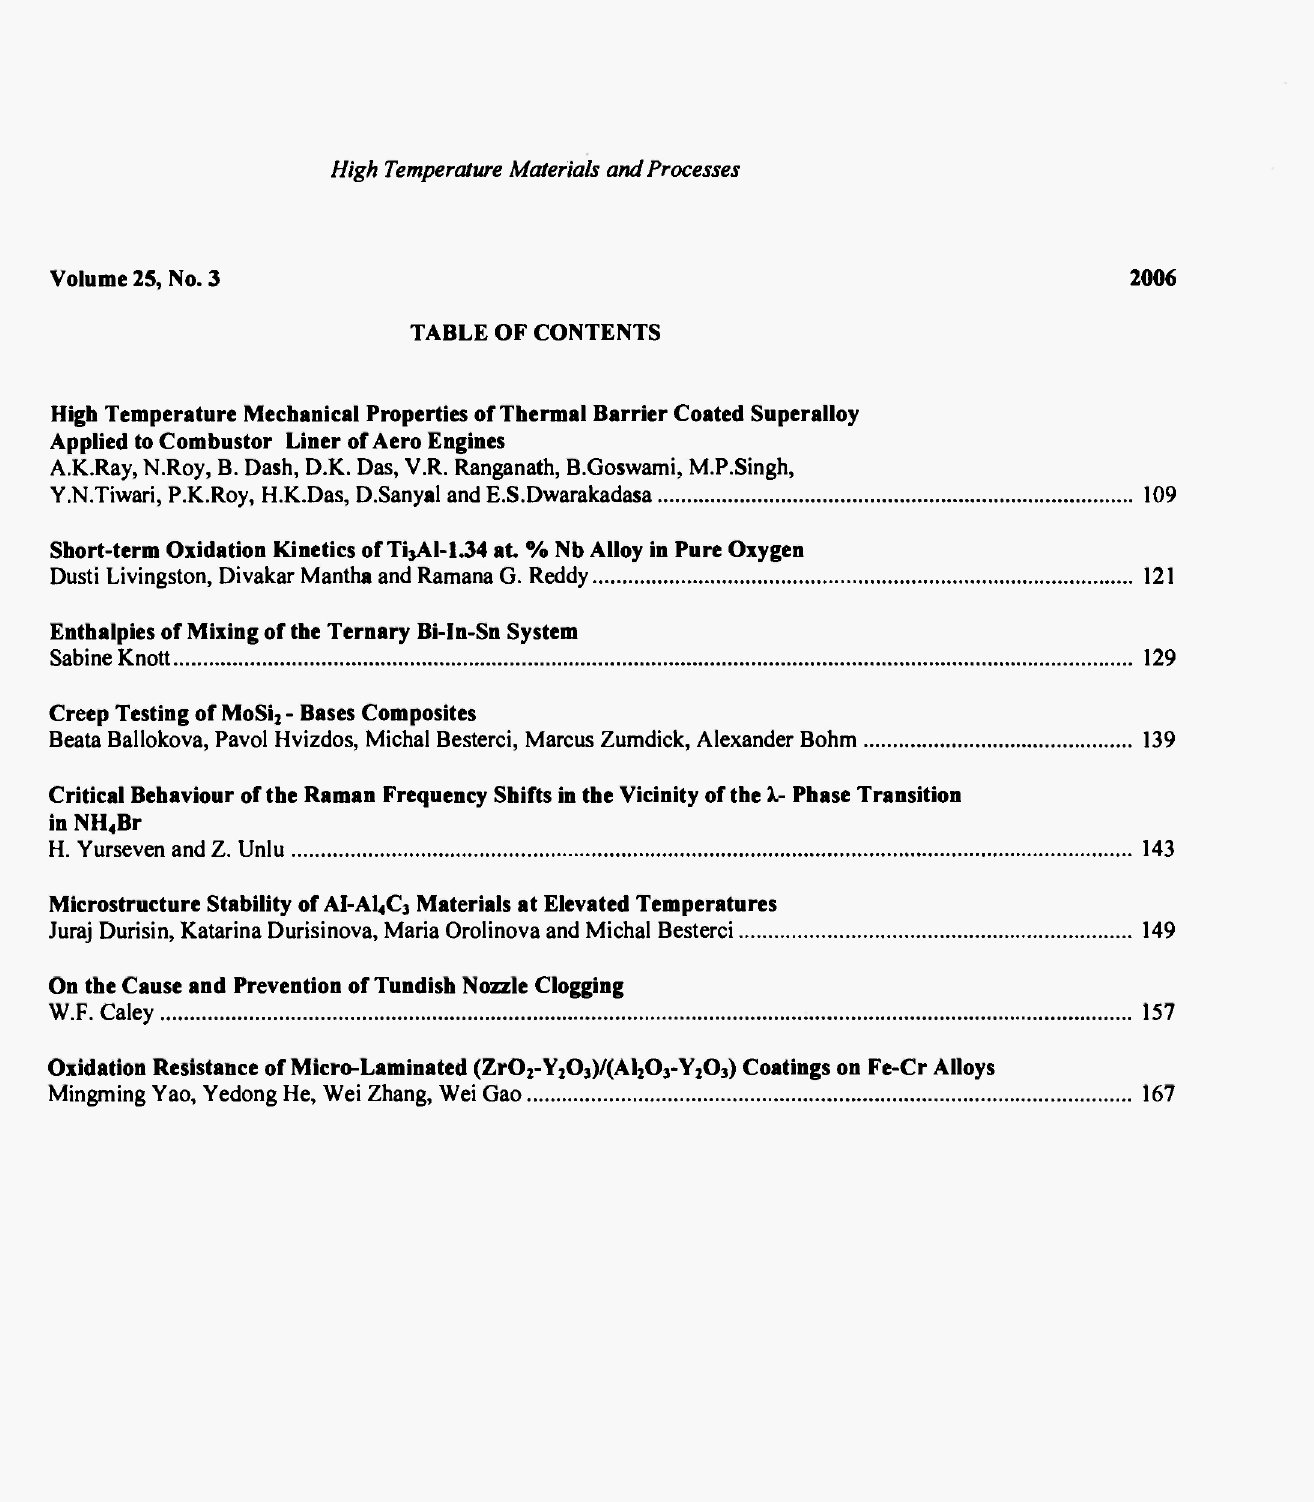
High Temperature Mechanical Properties of Thermal Barrier Coated Superalloy Applied to Combustor Liner of Aero Engines